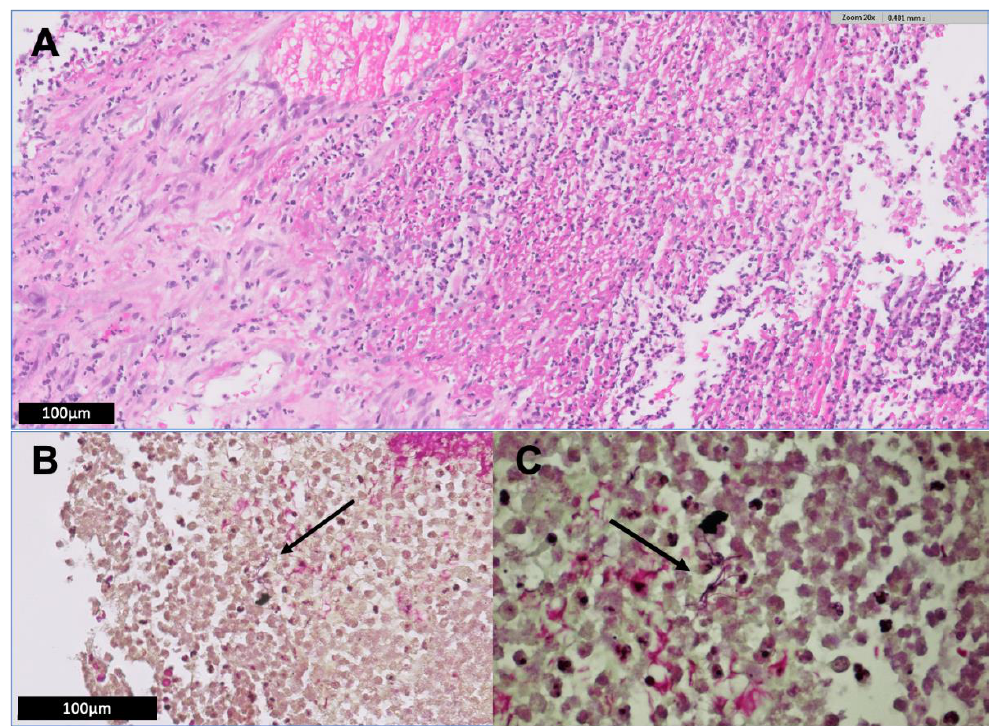
Figure 2. ( A ) Histologic examination of a retroperitoneal biopsy specimen demonstrates a diffuse neutrophilic infiltrate with necrosis and cellular debris. High magnification of a typical area of one of these abscesses with neutrophils, debris and liquefactive necrosis. Organisms are not visible on routine H&E stain. ( B , C ) Gram stain shows filamentous bacteria (arrows), consistent with Nocardia species. The organisms are Gram-variable or weakly Gram positive, thin and filamentous, and focally concentrated.